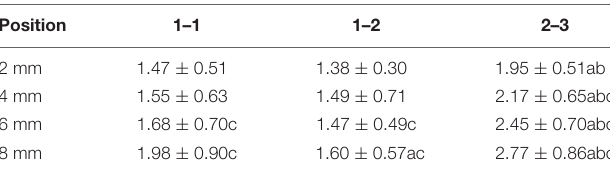
TABLE 2 | CBCT results of the mesiodistal dimension in the mandibular anterior tooth region (mm, ¯ x ± s).